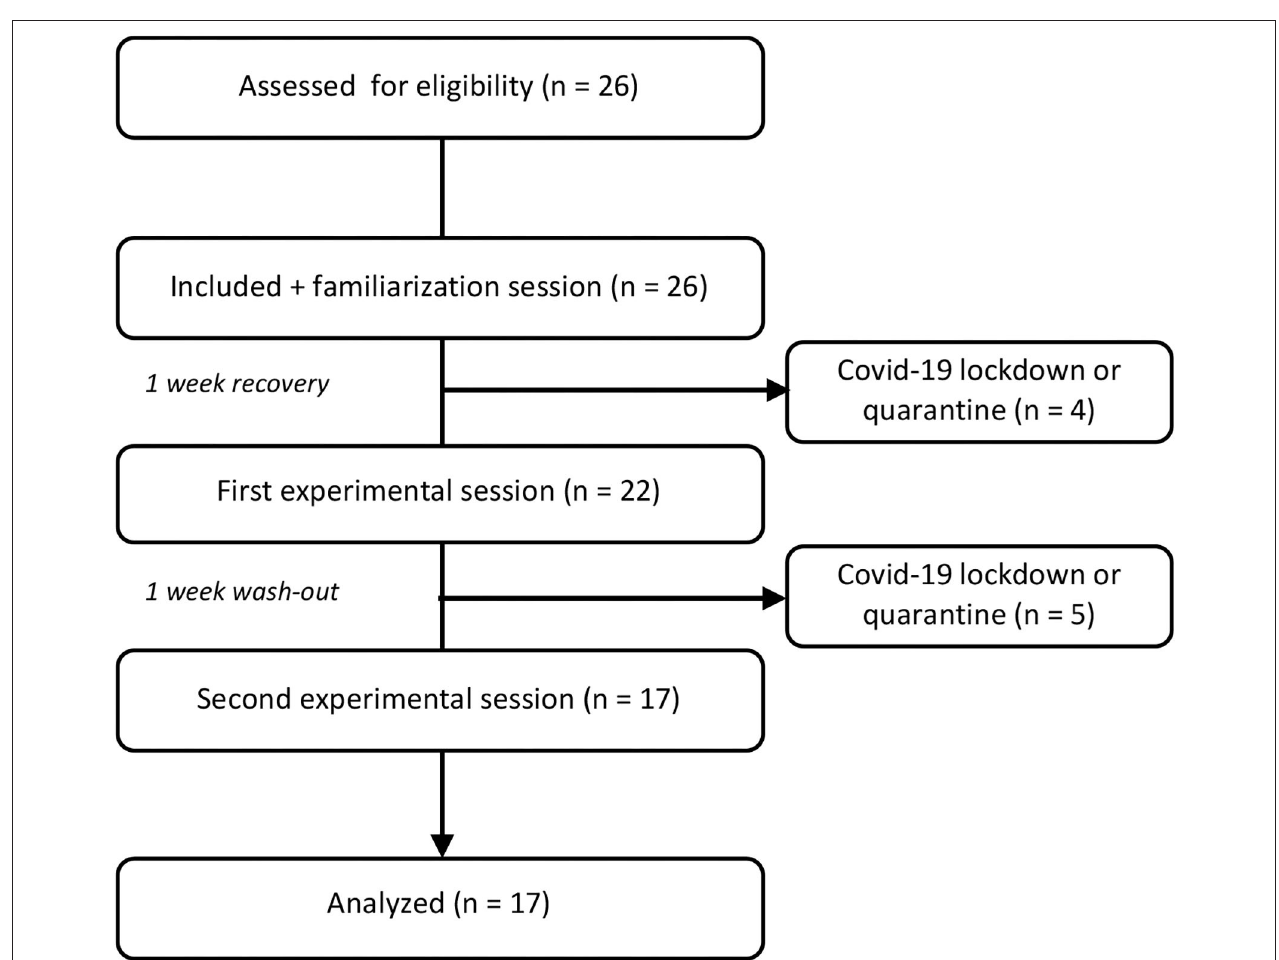
FIGURE 3 | CONSORT